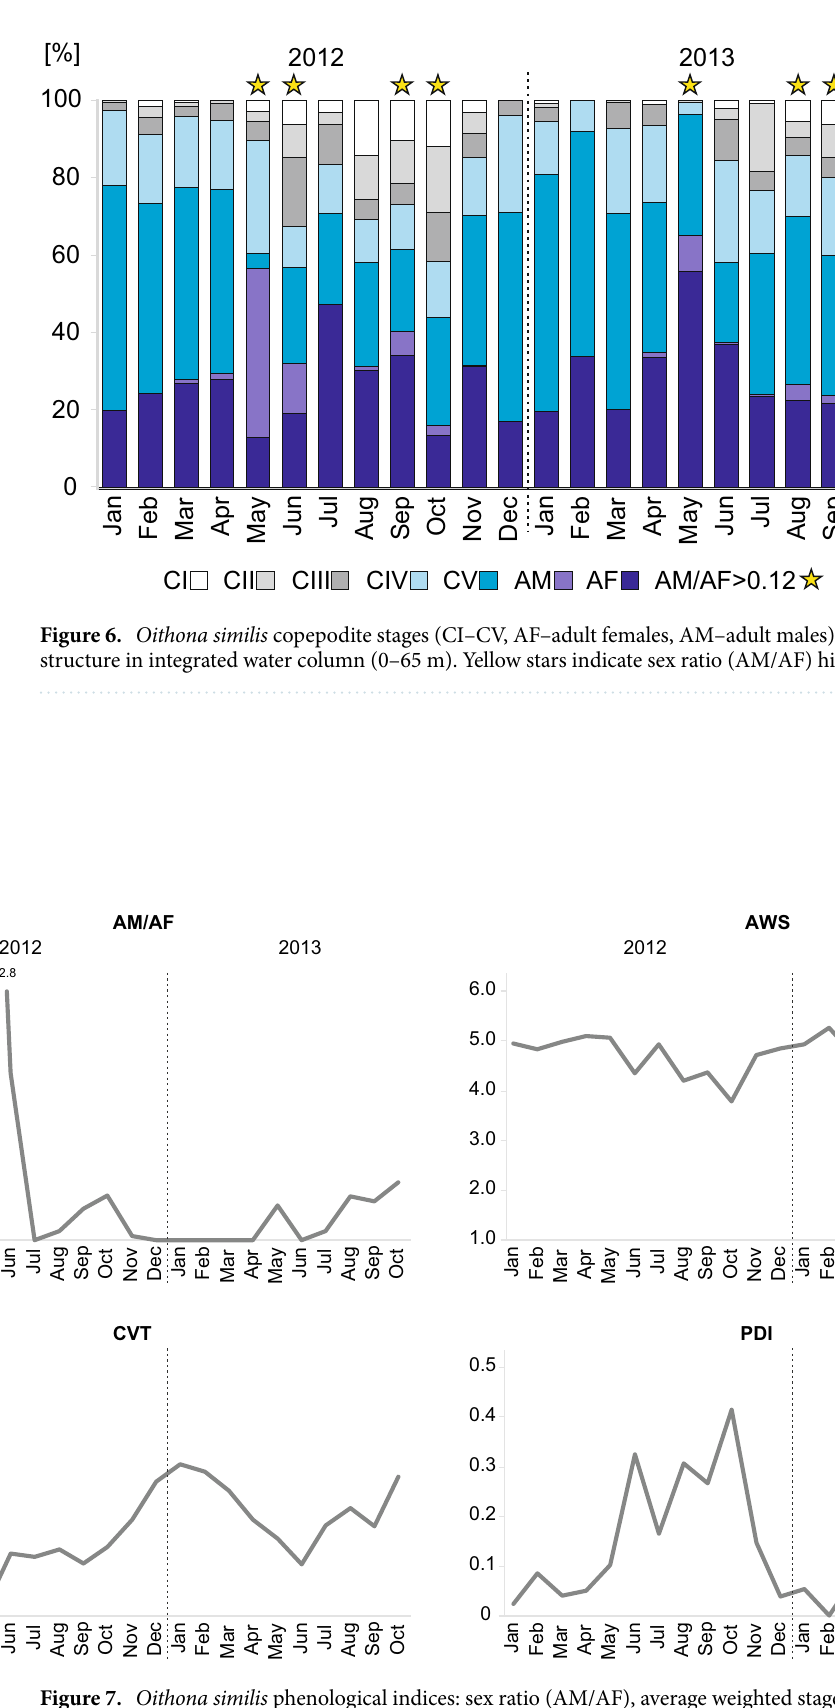
Figure 7. Oithona similis phenological indices: sex ratio (AM/AF), average weighted stage (AWS), the proportion of copepodite stages V to total abundance of copepodite stages (CVT) and population development index